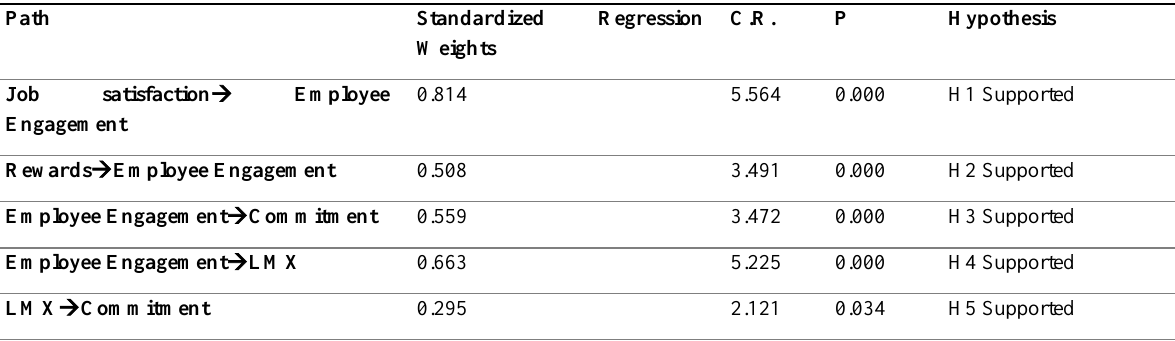
Table 2. Results of analysis of relationships between variables